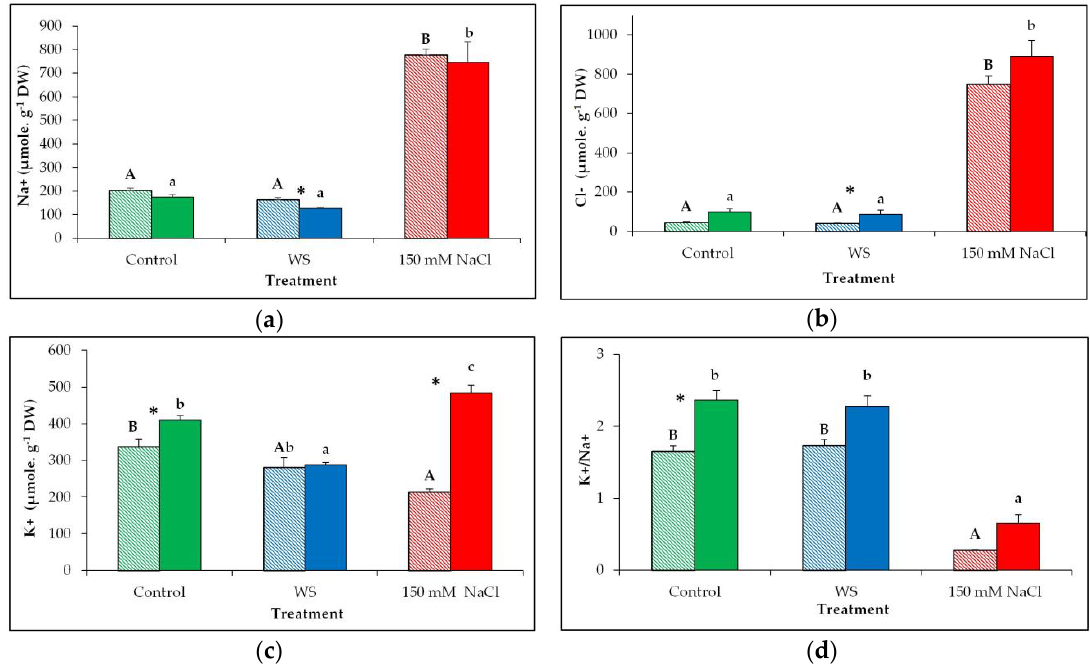
Figure 5. Monovalent ion contents in roots (striped bars) and needles (solid bars) of Larix decidua after 30 days of water (WS) and salt stress (150 mM NaCl) treatments: ( a ) sodium; ( b ) potassium; ( c ) chloride; ( d ) ratio potassium over sodium. Values shown are means ± SE ( n = 7). Different letters (lowercase for roots and capital for needles) above the bars indicate significant differences between treatments, and asterisks significant differences between roots and needles for the same treatment, according to Tukey’s test ( α = 0.05).